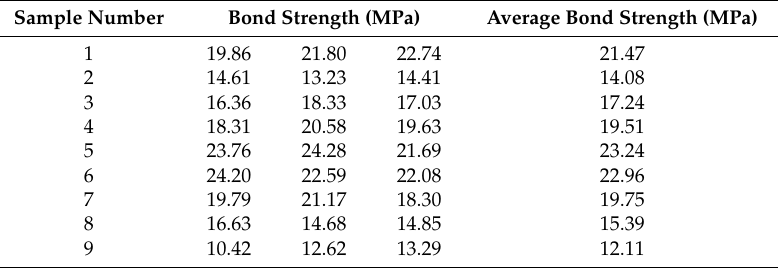
Table 3. Bond strength of the AT13 coatings prepared at designed